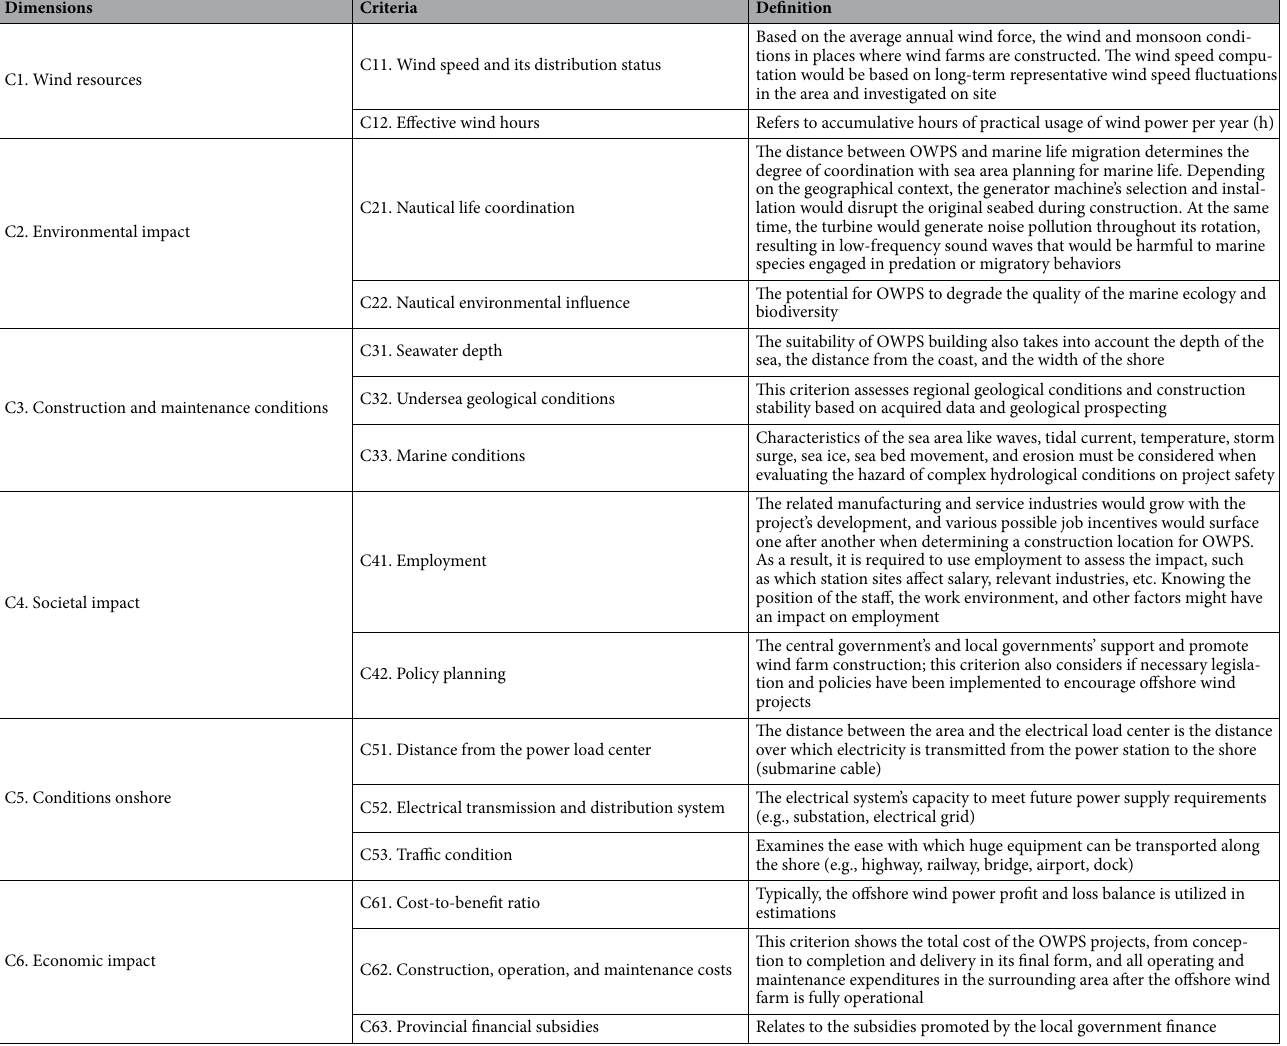
Table 5. The criteria used in the paper and their